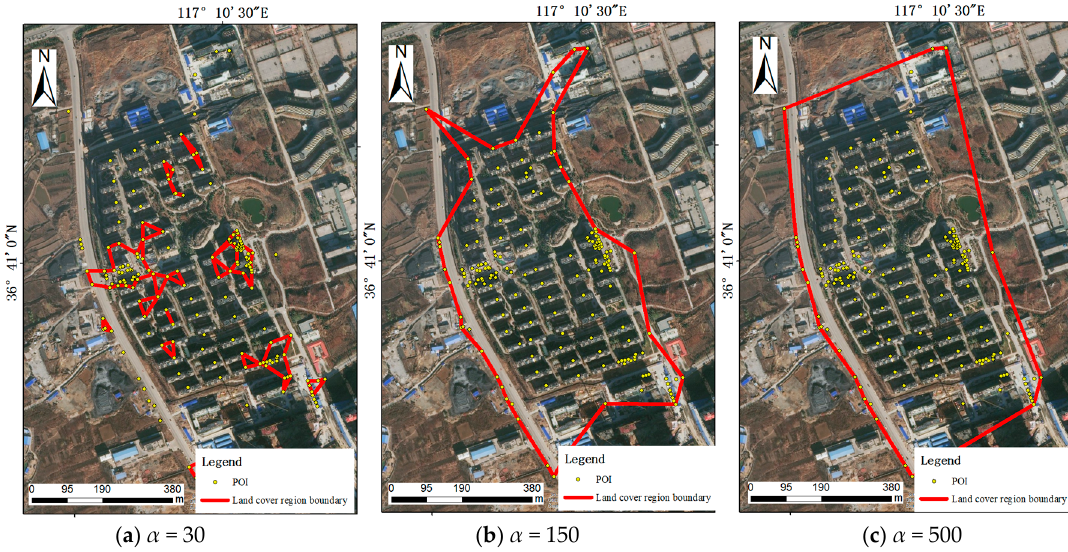
Figure 8. Land cover region extraction with different parameter α in one region.